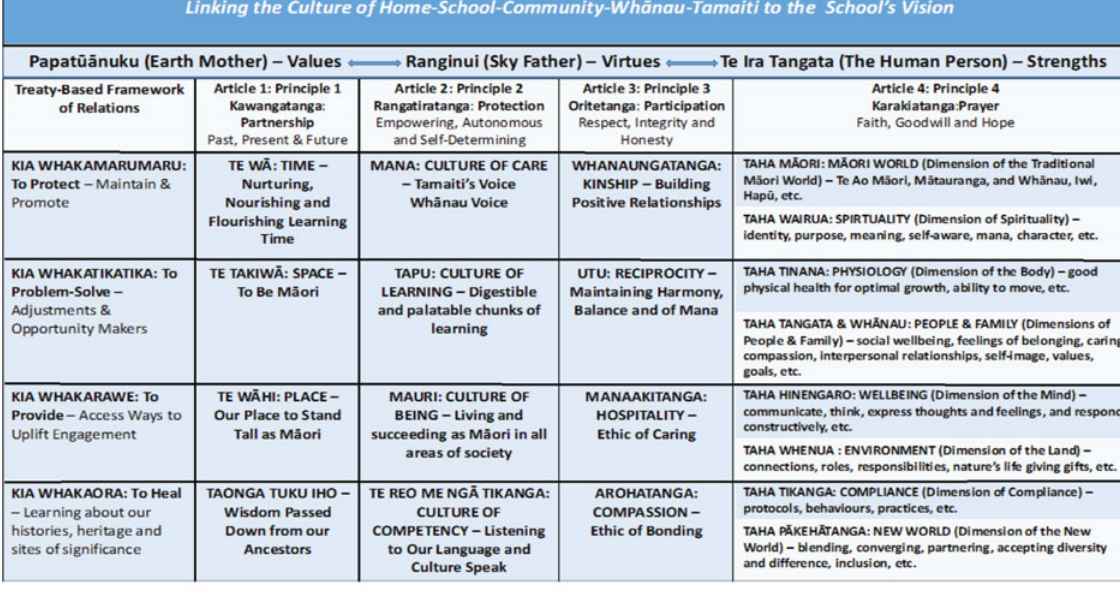
(Colour online) Linking the culture of home-school-community-Wh¯anau M¯aori – Tamaiti to the school’s vision. resourcing and professional development for